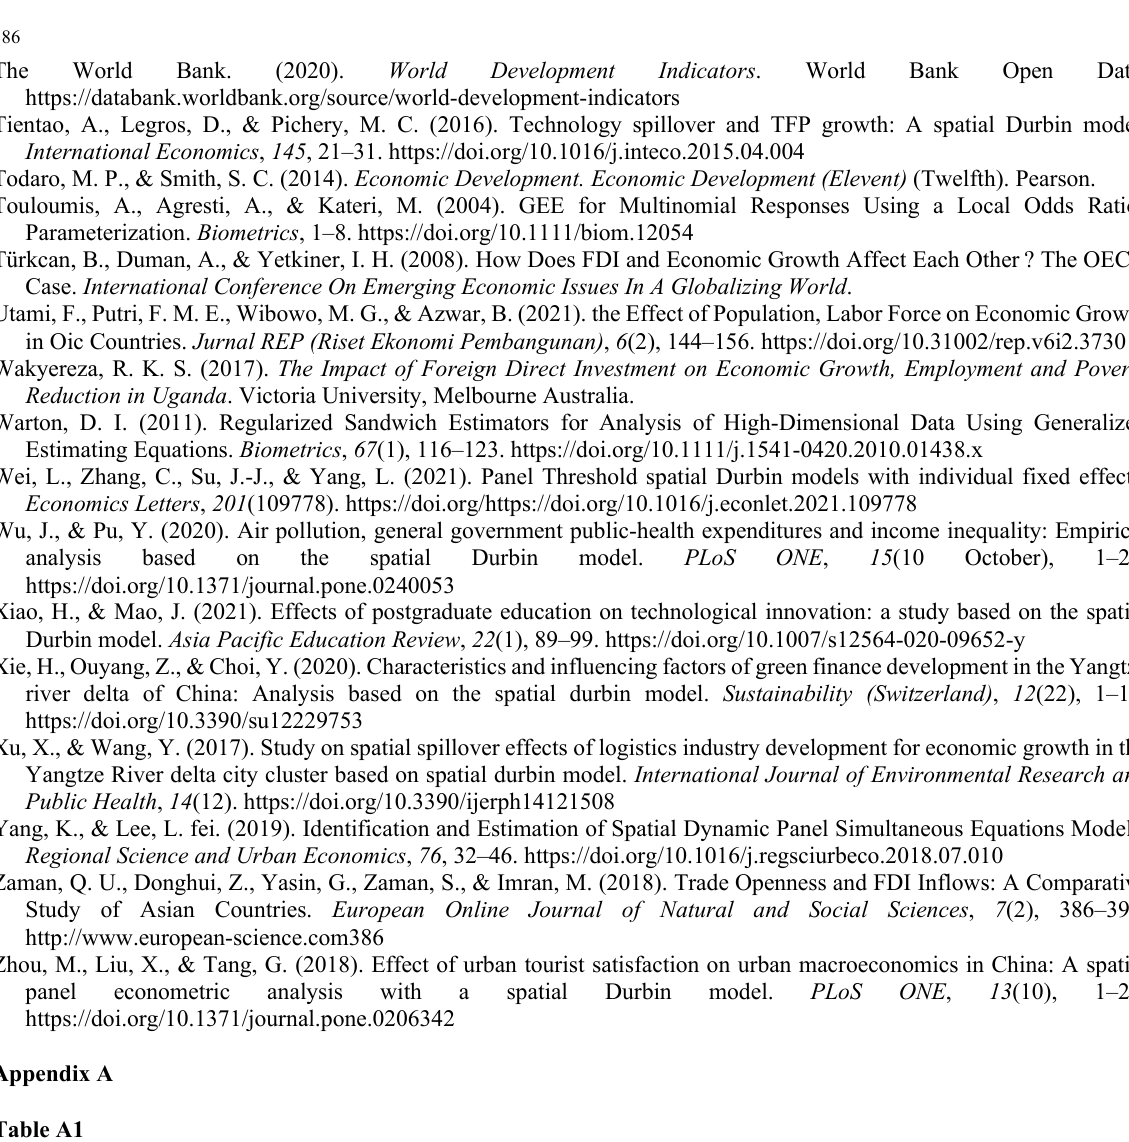
Queen contiguity weighted matrix. BRN KHM